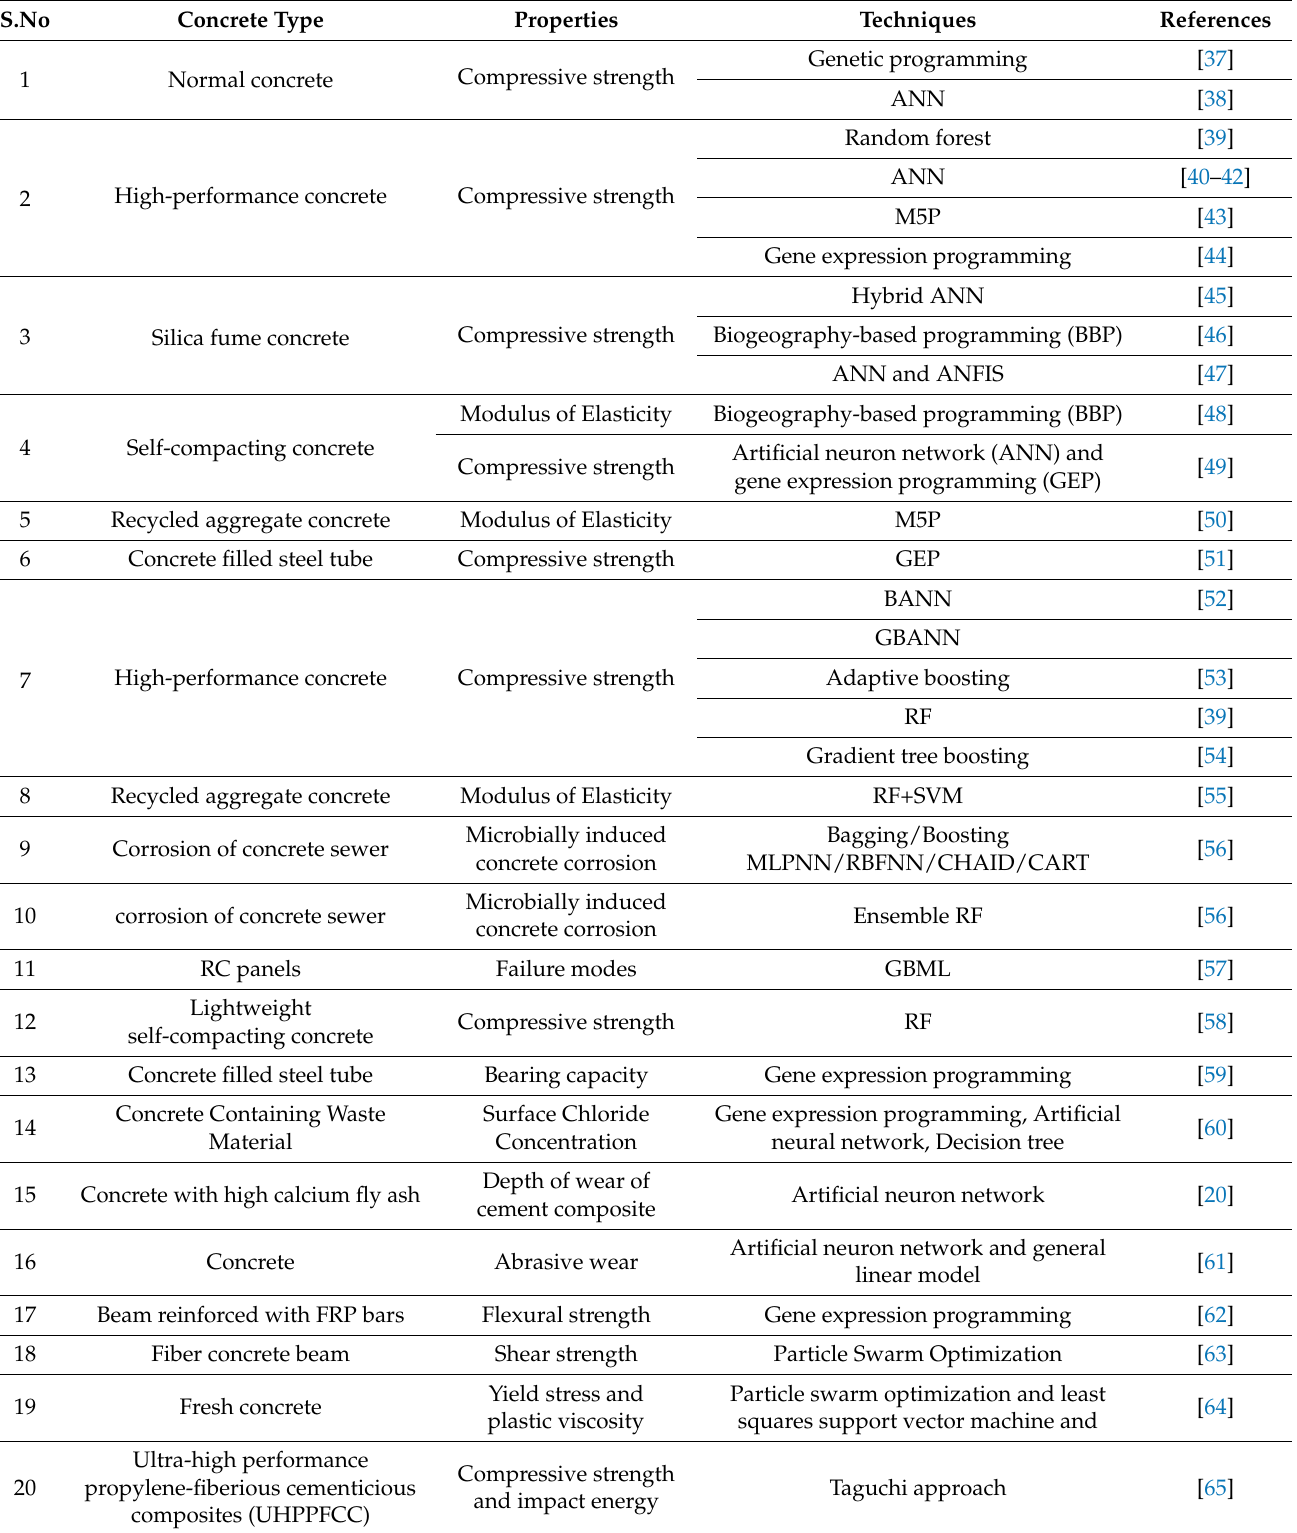
Table 2. Machine learning algorithm used by